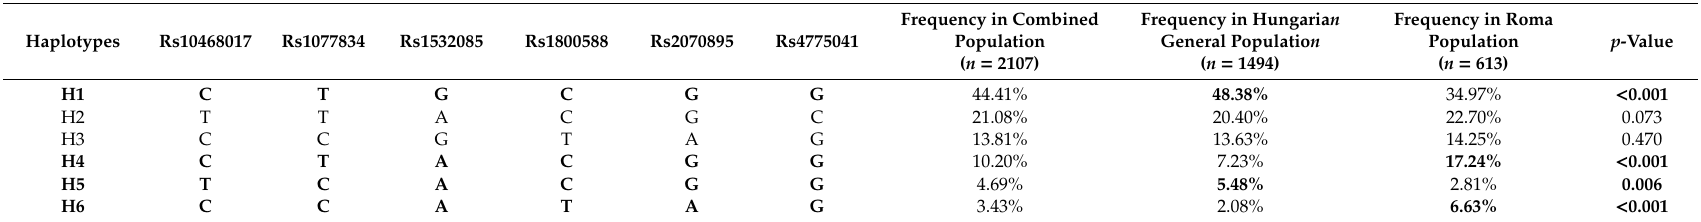
Table 3. The frequency of haplotypes in LIPC gene in the combined sample, as well as in Roma and Hungarian general populations.